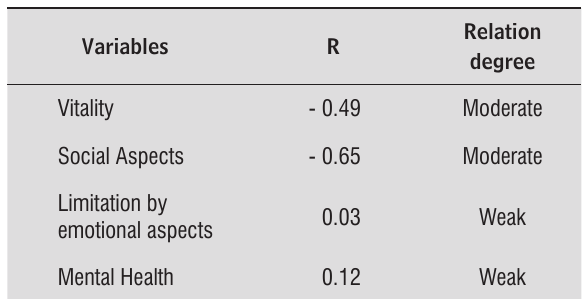
Table 2 - Standard deviation of the average related to age, SF-36, SF-36 components and Sleeping Quality Index in Pittsburgh, Maringá-PR.